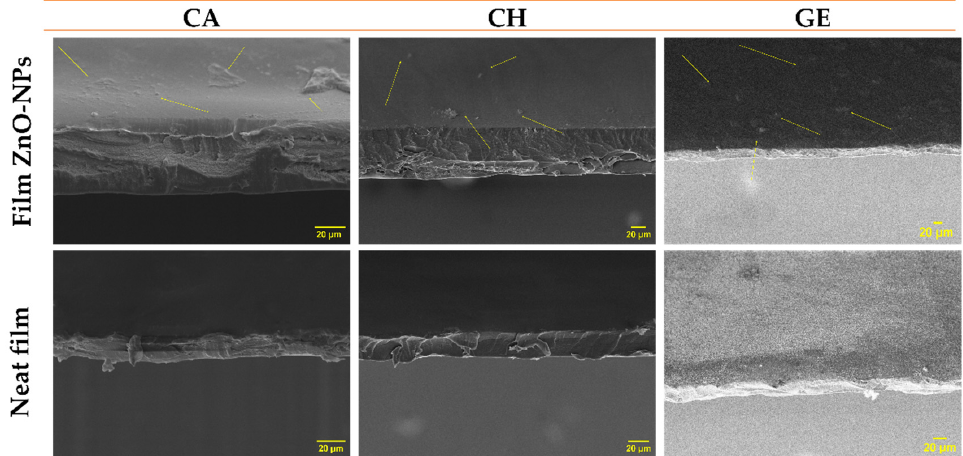
Figure 6. Scanning electron microscopy (SEM) images for the thickness and surfaces of the differ ‐ ent films reinforced with ZnO ‐ NPs (1.0% w / w ) (CA ‐ based, CH ‐ based, and GE ‐ based film ZnO ‐ NPs). Neat films without ZnO ‐ NPs (CA ‐ based, CH ‐ based, and GE ‐ based neat films) were added as